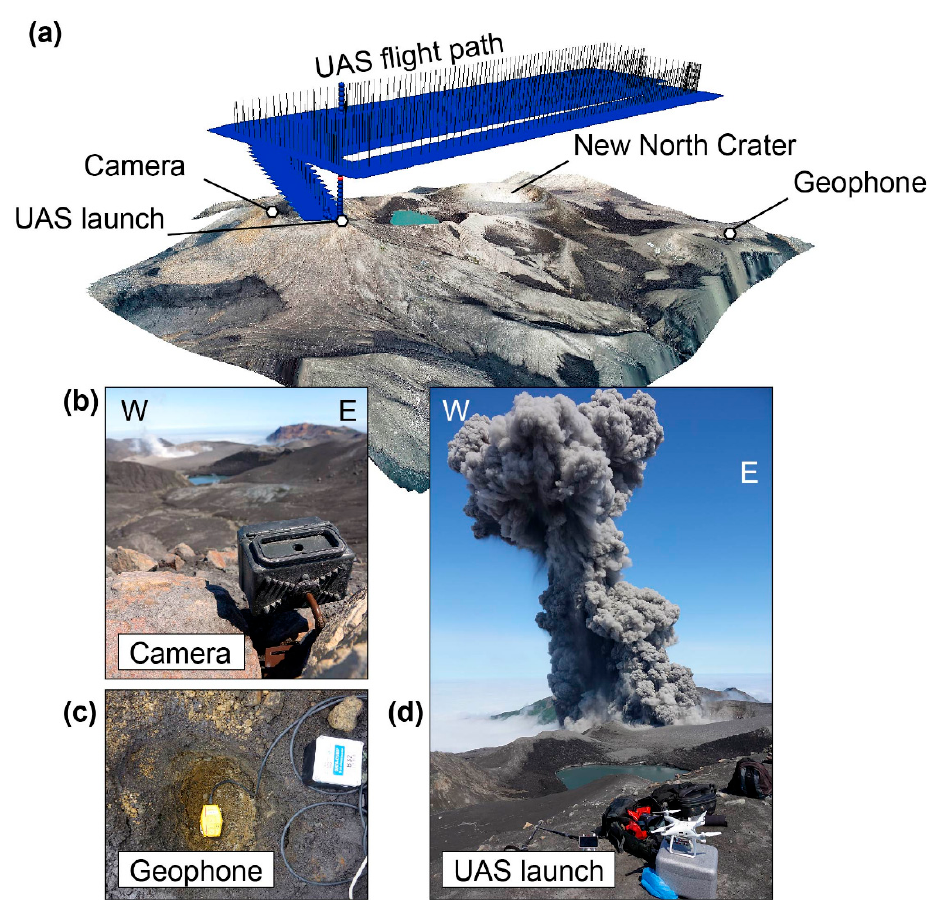
Figure 2. Field deployment ( a ) perspective map view of the active Ebeko crater, location of the camera and the geophone seismic station. The unoccupied aircraft system (UAS) launch site and flight path (indicated by blue cameras) are shown. ( b ) Time lapse camera looking northward to the active New North Crater (steaming in background) and ( c ) geophone (yellow) installed and buried at 1 m depth recorded by a DSS data cube (right). ( d ) The UAS launch site and explosion at the active crater on 2019-07-13 at 23:40 UTC.